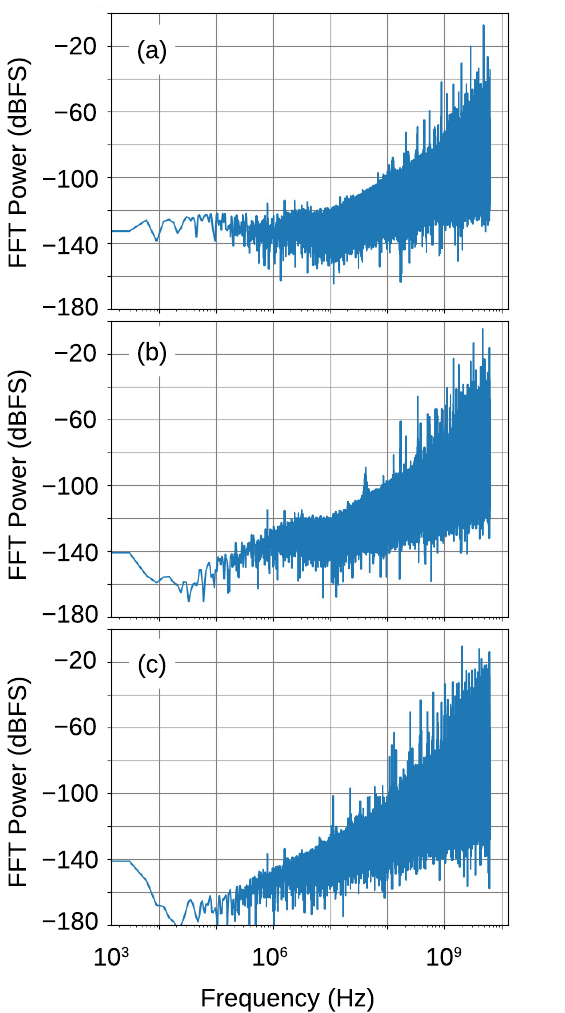
Figure 16. FFT spectra of the output PDM signals from the FPGA. The top figure ( a ) shows the result of the reflection oscillator in the previous work. The second figure ( b ) shows the result of the trans- mission oscillator, and the bottom figure ( c ) shows that of the transmission oscillator when the signal was down-converted by the mixer with 9.2 GHz LO. The results are normalized by the full-scale input, f s